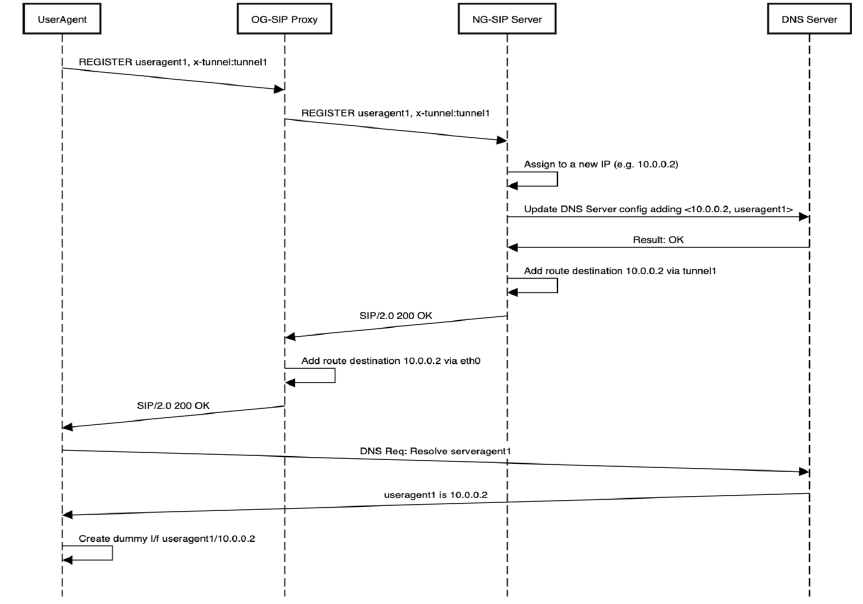
Figure 6. Example of SIP registration sequence and logical IP address assignment in